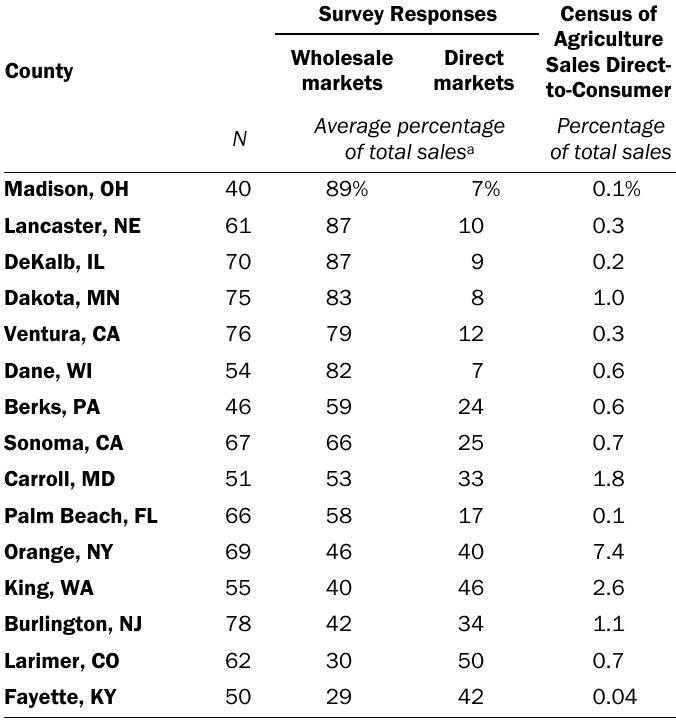
Table 2. Wholesale and Direct-to-Consumer Markets in 15 Counties: Survey Responses and Census of